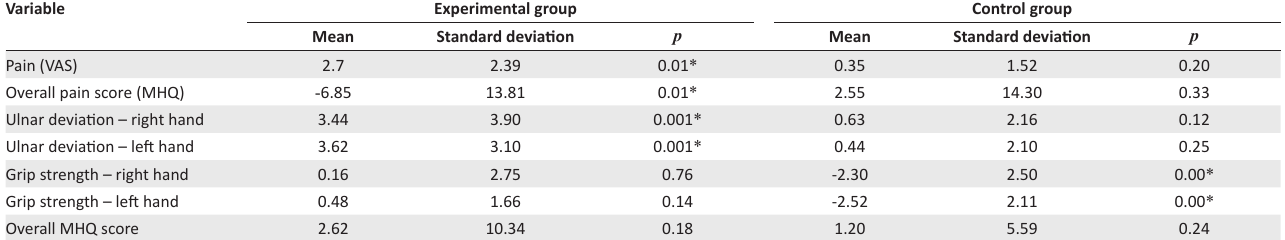
FIGURE 2: Representation of the procedures for the Kinesio Taping ® group and JP workshop group. TABLE 1: Paired t -test for changes over time for pain, MCP ulnar deviation, grip strength and overall MHQ score for the experimental group and control groups. Variable Experimental group Control